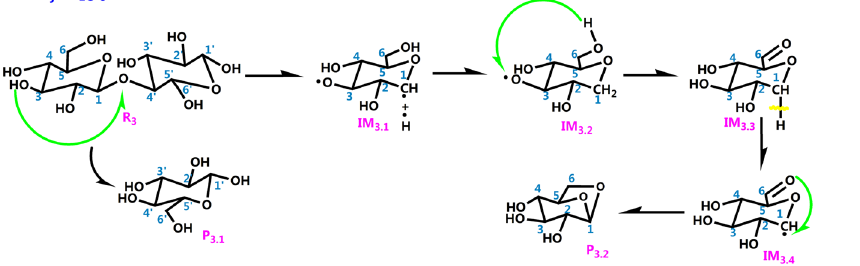
Figure 7. Pathway 3 reaction